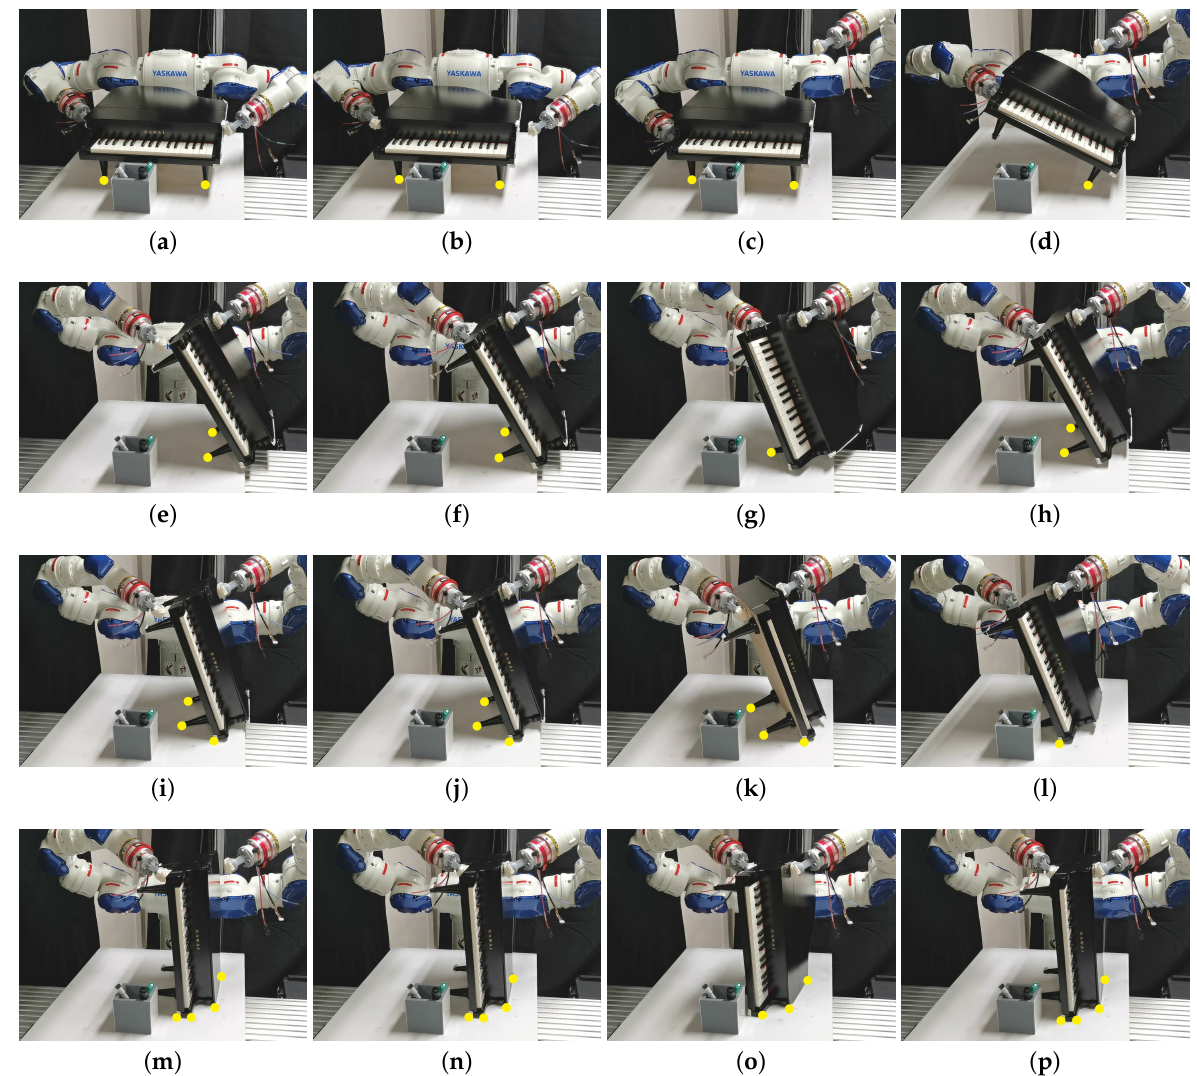
Figure 18. Experiment 3: An obstacle is placed in front of the object, see ( a , b ). The robot tumbles the object using the robot’s right EEF, whereas the left EEF moves to the desired position and waits for contacting the object ( c , d ). After the left EEF holds the object, the right EEF moves to the desired grasp pose ( e , f ). Note that the object is close to the boundary of the table and it is in a USP pose where the object will fall if there is no support from the EEF. After regrasping, the robot moves the object by pivoting it in the DS mode ( g , h ) and then places it in SP ( i ). The robot moves the object in the QS mode ( j , k ) and tumbles the object to change its support surface ( l , m ). Finally, the robot regrasps ( m , n ) and moves the object to the goal position ( o , p ). There is no collision between the object and obstacle during these